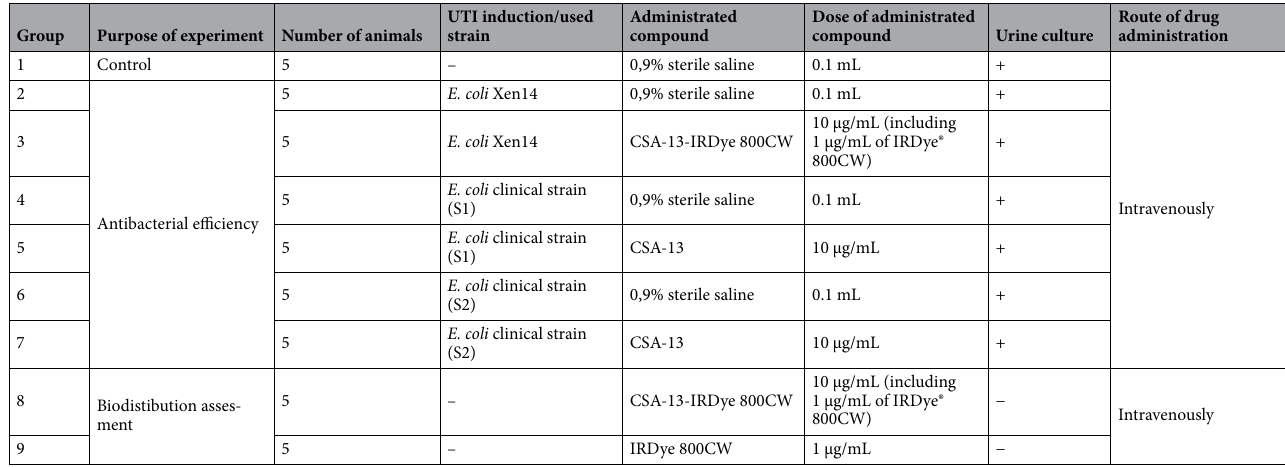
on their backs after being anesthetized with 5% isoflurane gas and then an inoculum of bacteria [ E. coli Xen14 (n = 5, groups 2–3), or 2 clinical strains of uropathogenic E. coli S1 and S2 (n = 5 per each group, groups 4–7)] in 50 μL phosphate-buffered saline (PBS; 1.2 × 10 7 CFU) was administrated over 30–45 s directly into the blad- der via urethral catheter 72 . Control mice (groups 1, 2, 4, 6) were injected with 0.1 mL of 0.9% NaCl. Following inoculation, the mouse bladders were drained for 4 h to ensure full E. coli adhesion with membrane receptors of bladder epithelial cells. The bacterial inoculum administered was consistent with previously published studies 73 . After bacterial challenge, the appropriate induction of urinary infection was confirmed by both culture of col- lected urine (bacteriuria) and histopathological evaluation of the urinary bladder (tissue edema, exfoliation of transitional epithelial cells, invasion of inflammatory cells in the mucosa, bladder mucosa hyperplasia), as well as changes in blood parameters (WBC, RBC, PLT)—Supplementary Table 1. Treatment procedure. Female mice, 24 h after bacterial challenge with E. coli Xen14, were divided into 2 groups: (1) UTI-suffering, untreated animals, which were dosed intravenously with 0.1 mL of 0.9% NaCl (n = 2; group 4), and (2) UTI-suffering animals, treated i.v. with CSA-13-IRDye800CW at a dose of 5 µg/g of body weight (n = 5; group 3). As a negative control, (3) healthy animals (not challenged with E. coli suspension) were treated with 0.9% NaCl (n = 5; group 1). Another group of mice, 24 h after bacterial challenge ( E. coli clinical strains, S1 and S2), were divided into 2 groups: (1) UTI-suffering, untreated animals, which obtained intrave- nously 0.1 mL of 0.9% NaCl (2 strains of clinical strains of E. coli , S1 and S2, 5 mice per group; groups 4 and 6), and (2) UTI-suffering animals, treated i.v. with CSA-13 at dosage of 5 µg/g of body weight (2 strains of clinical strains of E. coli , S1 and S2, 5 mice per group; groups 5 and 7). As a negative control, (3) healthy animals (not challenged with E. coli suspension) were treated with 0.9% NaCl (n = 5; group 1). Assessment of bacterial presence in urine. Urine was collected from the animals of groups 1–7 at the specified times (0, 4, 8, 12 and 24 h after treatment) by gentle compression of the bladder through the abdominal wall. A micropipette was used to extract urine samples (5 µL) from the external urethral meatus. Serial dilutions of urine samples were plated on MacConkey agar plates to determine bacterial counts. For the purpose of analysis of biodistribution of ceragenin, uninfected animals from groups 8 and 9 were injected intravenously with CSA-13-IRDye800CW (n = 5) or unmodified IRDye800CW dye (n = 5), respectively. Mice were anesthetized with 3% isoflurane gas prior to imag- ing, and the entire animal was imaged for a period of 2 min using the Pearl®Trilogy small animal imaging system (Li-COR, Lincoln, NB, USA) at different times after treatment (0, 4, 8, and 12 h). Mice were held anesthetized